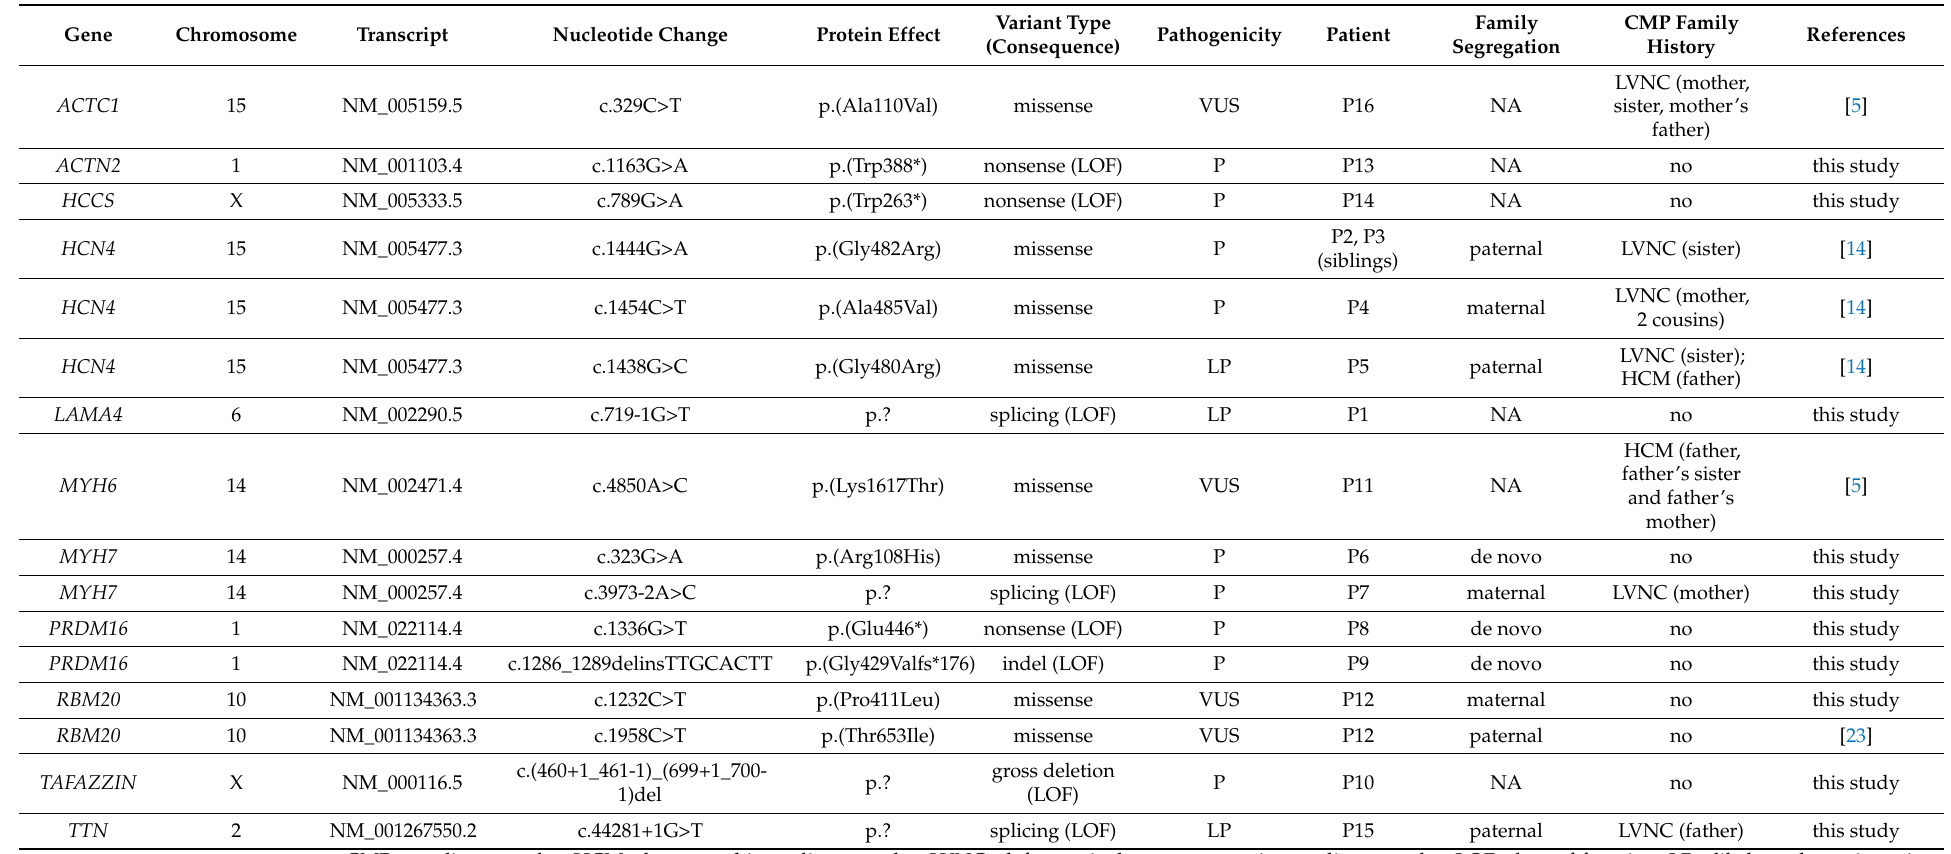
Table 2. List of putative disease-causing variants identified in this